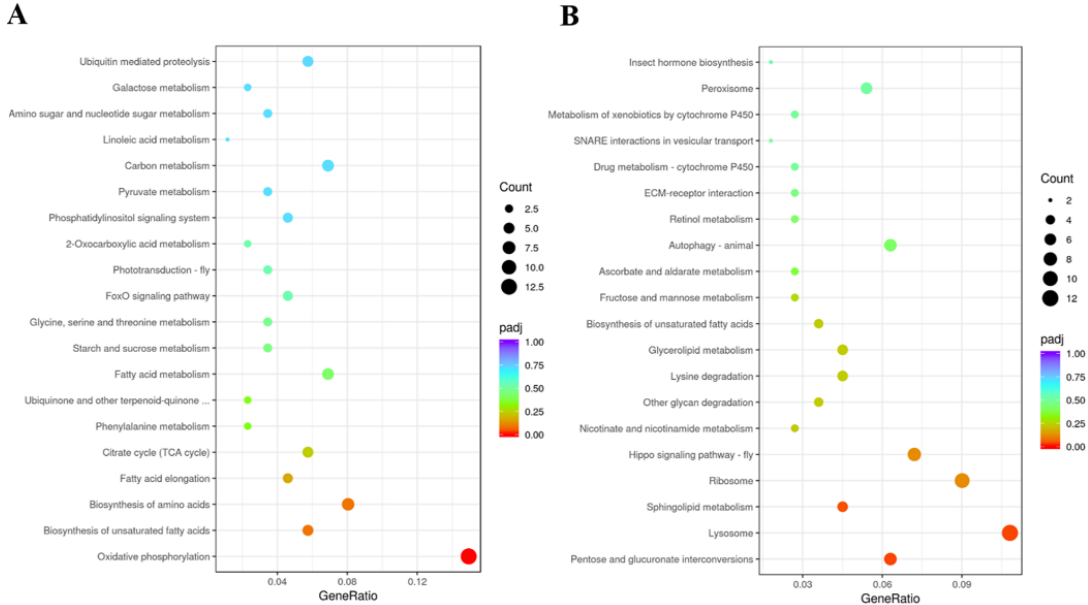
Figure 10. KEGG enrichment analysis of DEGs between ds DcTPS1 groups and ds GFP groups. The sizes of the bubble indicate the number of DEGs enriched in the KEGG pathway. The color of the bubble indicates the Q value. ( A ) Upregulated DEGs. ( B ) Downregulated DEGs.